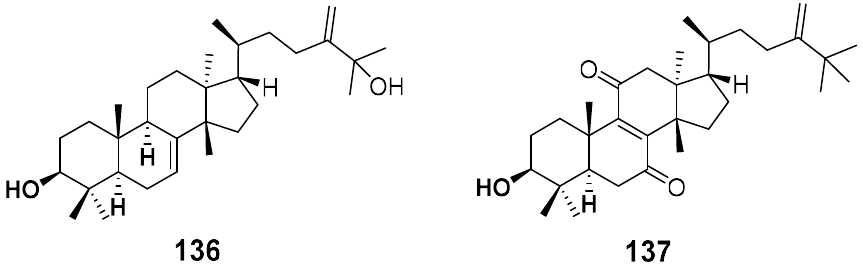
Figure 7. Structures of diterpenes identified in agarwood.